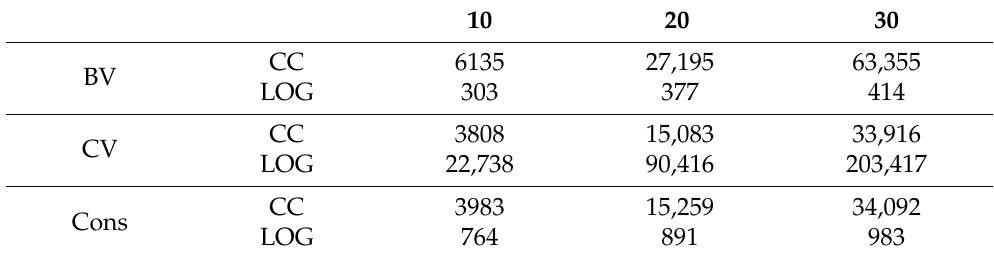
Table 2. Average sizes per problem produced by CC and LOG models using 10, 20, and 30